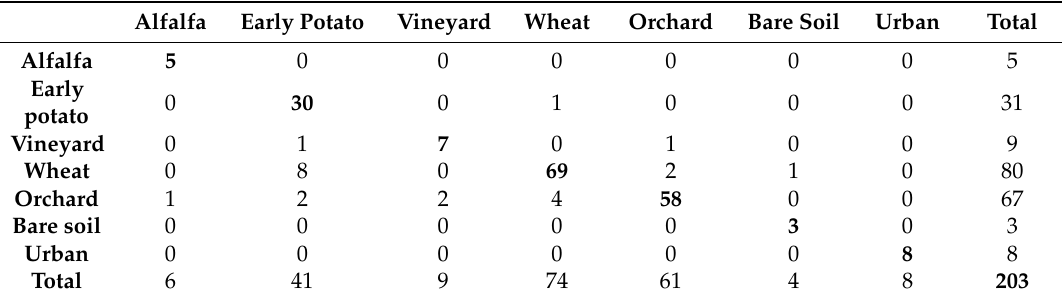
Table 3. Confusion matrix of the crop classification (spring 2017).